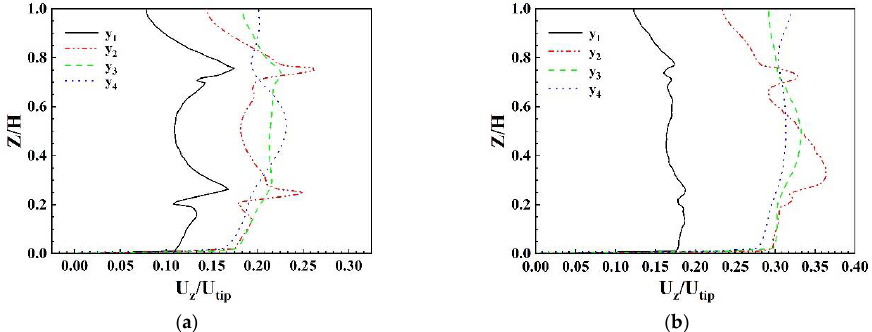
Figure 10. Velocity profile at different axial location. ( a ) DTBI; ( b ) DRFTBI. (Rotational speed: 120 rpm; solid loading: 30%; connection strap length: 1.2 Hs.)